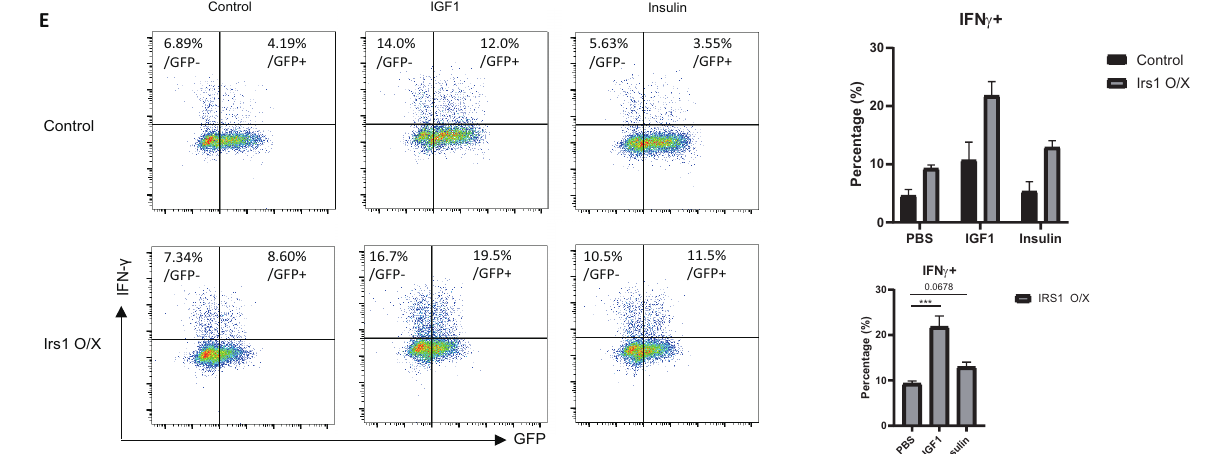
Figure 7. IRS1 signaling affects the stability and metabolism of Treg cells. ( A ) Heatmap of genes showing altered expression in IRS1-overexpressing Treg cells compared with controls. ( B ) GSEA analysis of “ Ifng -associated genes” and “glucose uptake-associated genes” in control and IRS1- overexpressing Treg cells. ( C ) IFN- γ expression in IRS1-overexpressing Treg cells was measured via flow cytometry. Cells were gated on FOXP3+, and the ratio of IFN- γ + cells to GFP- or GFP+ cells was measured. ( D ) RNA was isolated from sorted GFP+ cells, and expression of Ifng was measured via qRT-PCR. ( E ) Retroviral transduction of MIEG3-IRS1 vector was performed as in Figure 2. After transduction, PBS or IGF1 (100 ng/mL) or insulin (100 ng/mL) were treated and cultured for 2 days under Treg conditions. IFN- γ expression was measured via flow cytometry. ( F ) RNA was isolated from sorted GFP+ cells, and Glut1 was measured via qRT-PCR. Flow cytometry and qRT-PCR data are representatives of three independent experiments. The bar graph next to the flow cytometry plot shows that data were pooled from three independent experiments. The error bars represent the SD, and ( C , D , F ) p -values were calculated using a t -test. ( E ) p -value of the bottom graph was calculated using one-way ANOVA/Tukey test. * p < 0.05, ** p < 0.01, *** p <